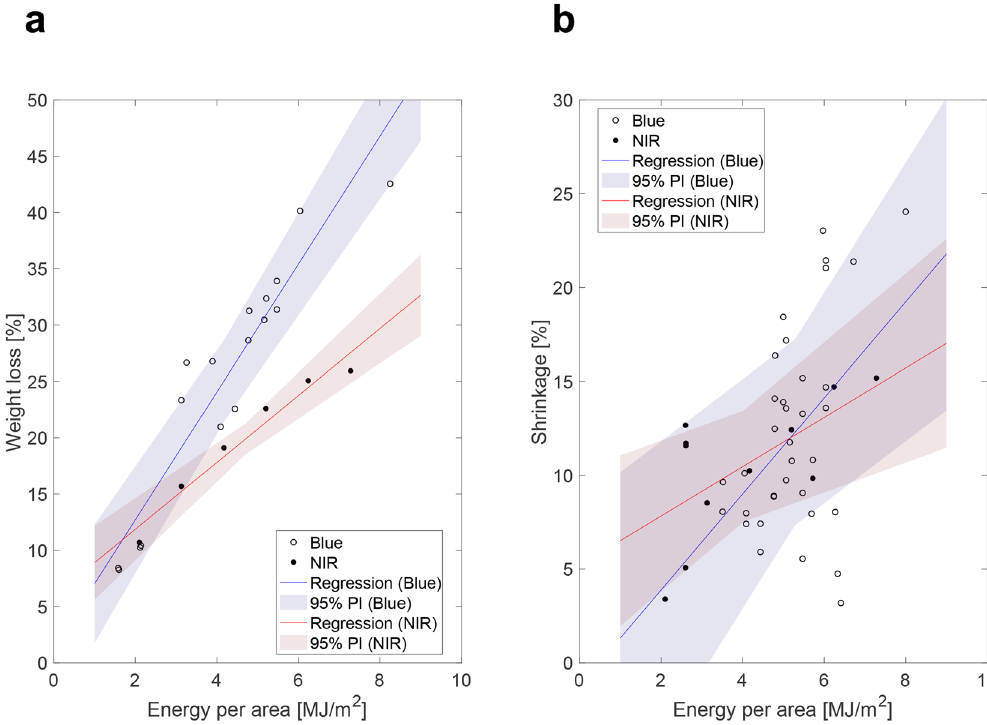
Fig. 6 Effect of heat exposure time on weight loss and shrinkage in printed chicken samples. Each data point from each graph was from a different cooking test. a Weight loss percentage as a function of energy per area for laser-broiled and oven-broiled samples (sample size was 17 for blue laser tests and 6 for NIR laser tests). The power of both the blue and NIR lasers was 5 W for these trials. b Shrinkage as a function of energy per area for laser-broiled samples (sample size was 35 for blue laser tests and 11 for NIR laser tests). The power of both the blue and NIR lasers was varied from 5 to 10 W for these trials. Energy per area was calculated by taking the product of the laser power and the exposure time and dividing by the area of the food sample. Shaded regions represent the standard error estimate of the sample set, showing a 95% prediction interval based on the collected data.